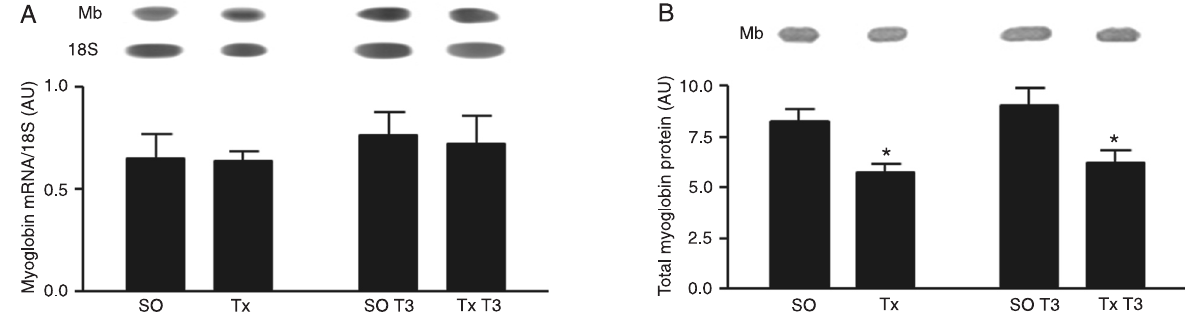
Figure 2. Effect of thyroidectomy on myoglobin (Mb) mRNA and protein expression in rat masseter muscle. Panels A and B show the Mb mRNA and protein content, respectively, in masseter muscle of sham-operated (SO), thyroidectomized (Tx), sham-operated T3- treated (SO T3), and Tx rats chronically treated with T3 (Tx T3). The T3 dose used was 5 μg/100 g body weight, for 15 days. Typical representative blots of Mb and 18S transcripts (A) and Mb protein (B) are given at the top of the panels. Three experiments were per- formed with 4 animals per group (N = 48). Data are reported as means ± SEM, expressed in arbitrary units (AU), and were analyzed by two-way analysis of variance (ANOVA), followed by the Bonferroni post-test. *P < 0.05 vs SO and SO